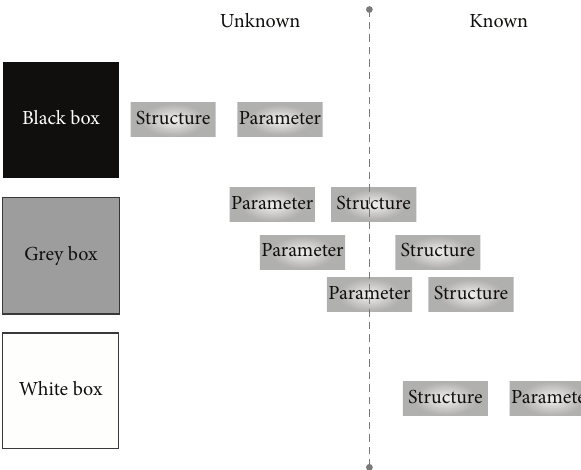
Figure 4: Classification of dynamical systems by model structure and parameter.